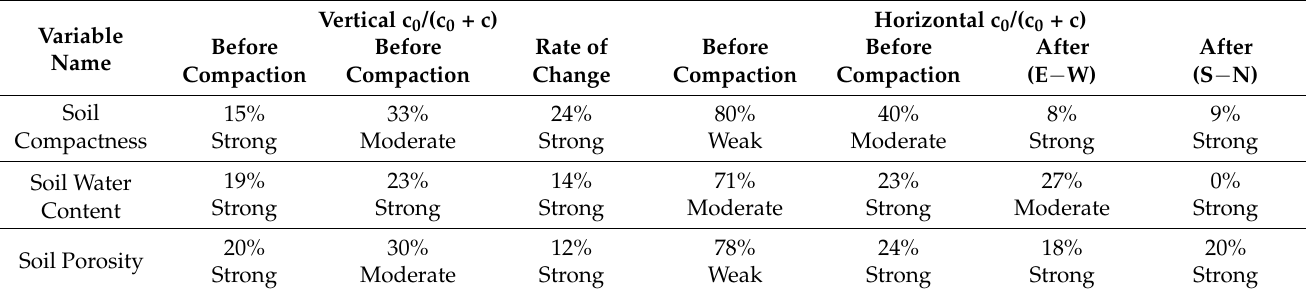
Table 4. Values of c 0 /(c 0 + c) for the semi-variance function of soil parameters in the tillage layer before and after